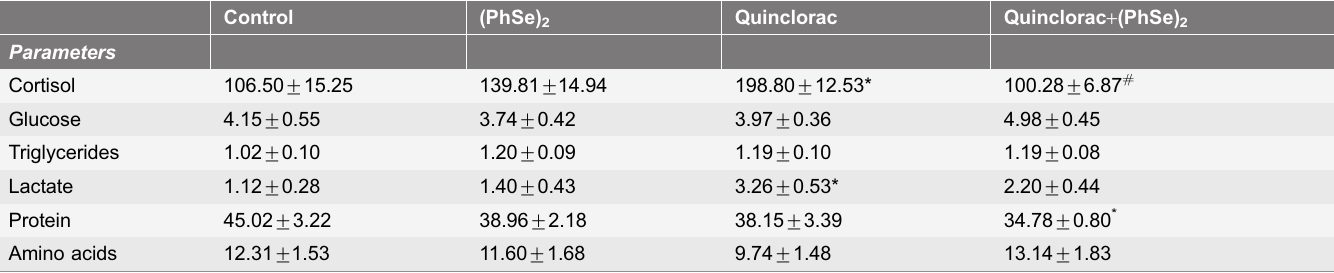
Table 2. Metabolic